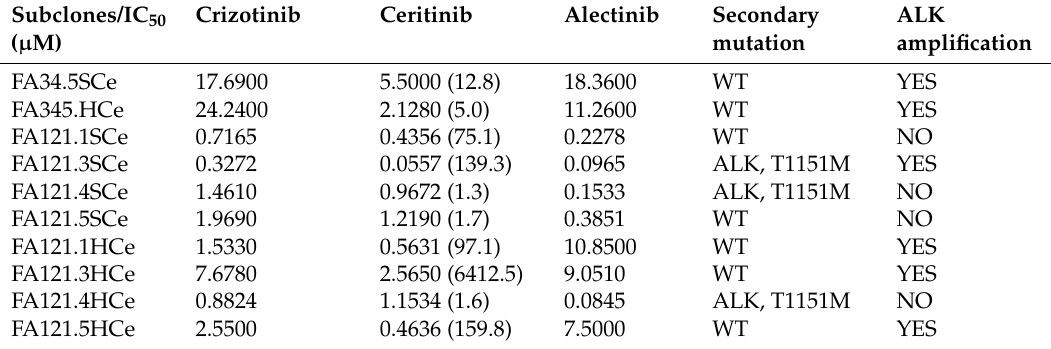
C. IC 50 values and the resistant mechanisms of different ceritinib-resistant subclones against the three ALK-TKIs